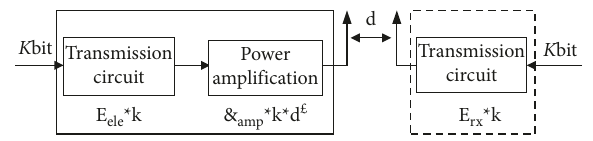
Figure 10: Energy consumption